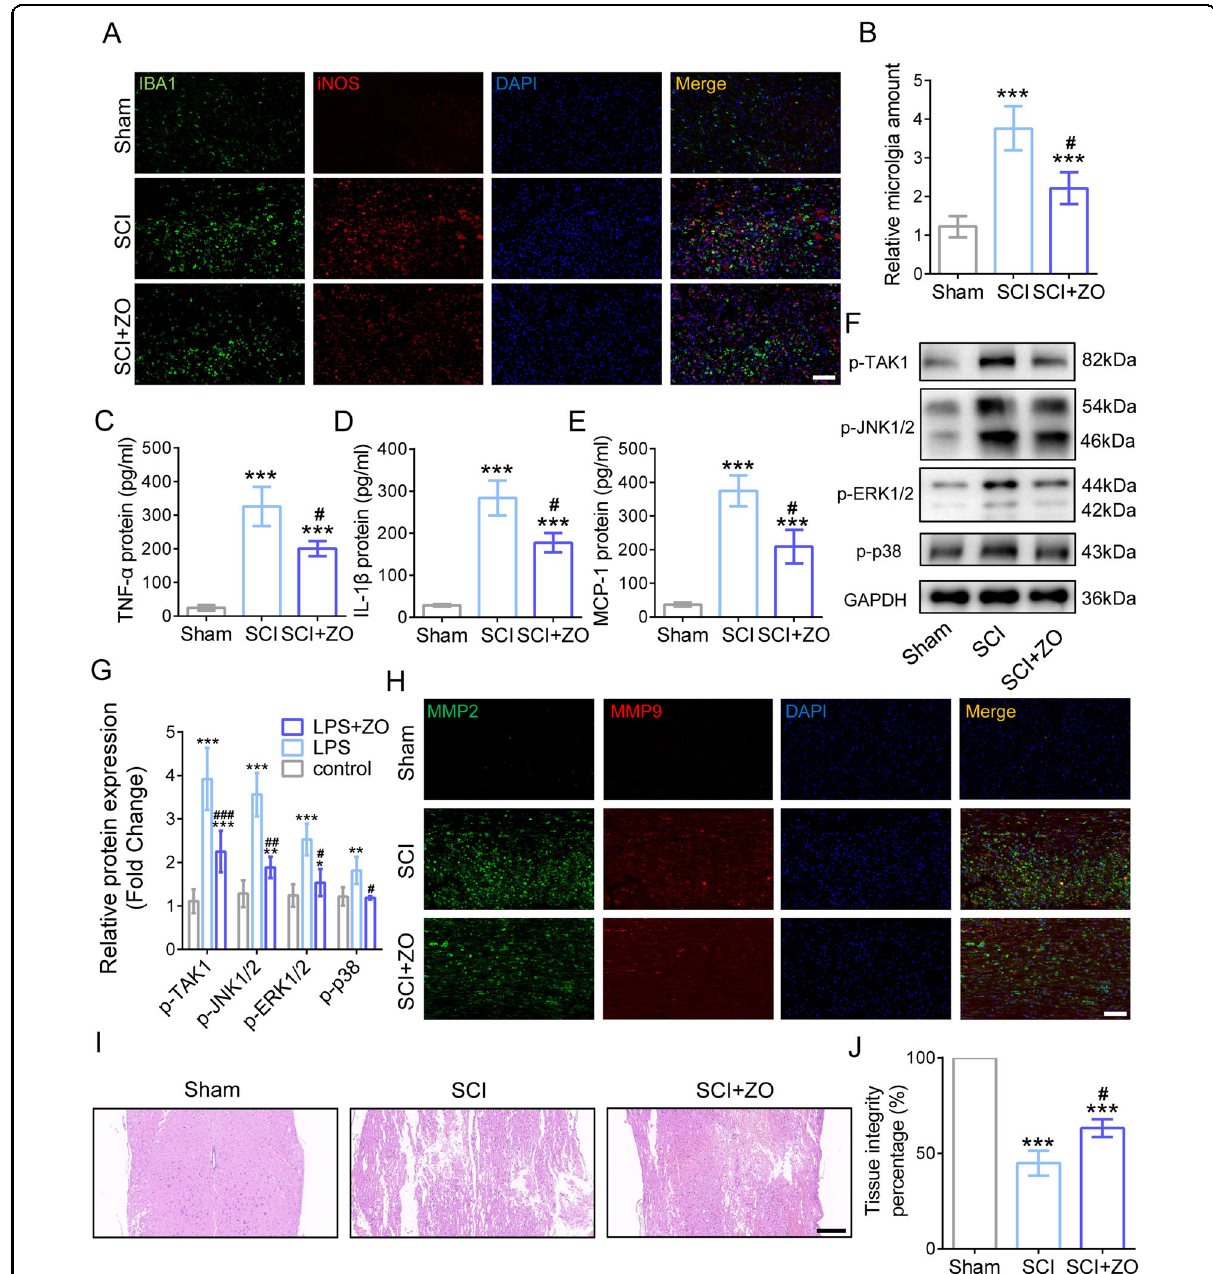
Fig. 4 TAK1 inhibition ameliorates neuroin fl ammation and tissue destruction caused by microglia and MMPs generation. A Representative IF images of IBA1 and iNOS after LPS inducement and ZO administration; Bar scale = 100 μ m. B The amount of microglia under LPS and TAK1 inhibition treatment. ∗∗∗ P < 0.001 versus Sham group, # P < 0.05 versus SCI group. The protein levels of TNF- α , IL-1 β , and MCP-1. ∗∗∗ P < 0.001 vs. Sham group, # P < 0.05 vs. SCI group C – E . F Western blotting of p-JNK1/2, p-ERK1/2 and p-p38. G Quanti fi cation of p-JNK1/2, p-ERK1/2, and p-p38. ∗ P < 0.05, ∗∗∗ P < 0.001 versus Sham group, # P < 0.05, ## P < 0.01, ### P < 0.001 versus SCI group. H Representative IF images of the expressions of MMP2 and MM P 9 in injured cords; Bar scale = 100 μ m. I Representative HE staining photos of spinal cord in Sham, SCI, SCI + ZO group at 3dpi; Bar scale = 200 μ m. J Quanti fi cation of tissue integrity in the spinal